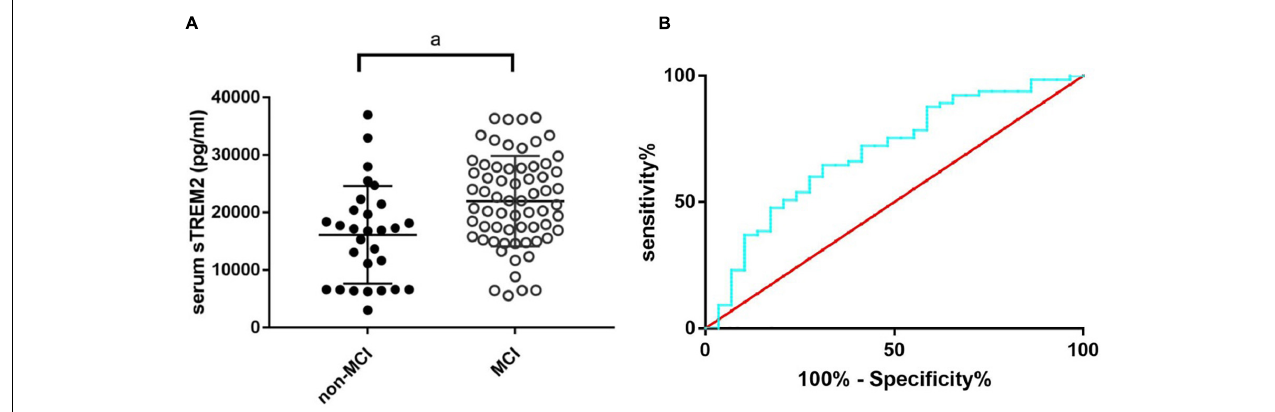
FIGURE 3 | The sTREM2 level in OSA patients with and without MCI (A) and the ROC curve analysis of serum sTREM2 in discriminating OSA patients with MCI from those without (B) . The comparison was evaluated by t -test; a, compared with the control group, p < 0.05. MCI, mild cognitive impairment; OSA, obstructive sleep apnea; ROC, receiver operating characteristic; sTREM2, soluble triggering receptor expressed on myeloid cells